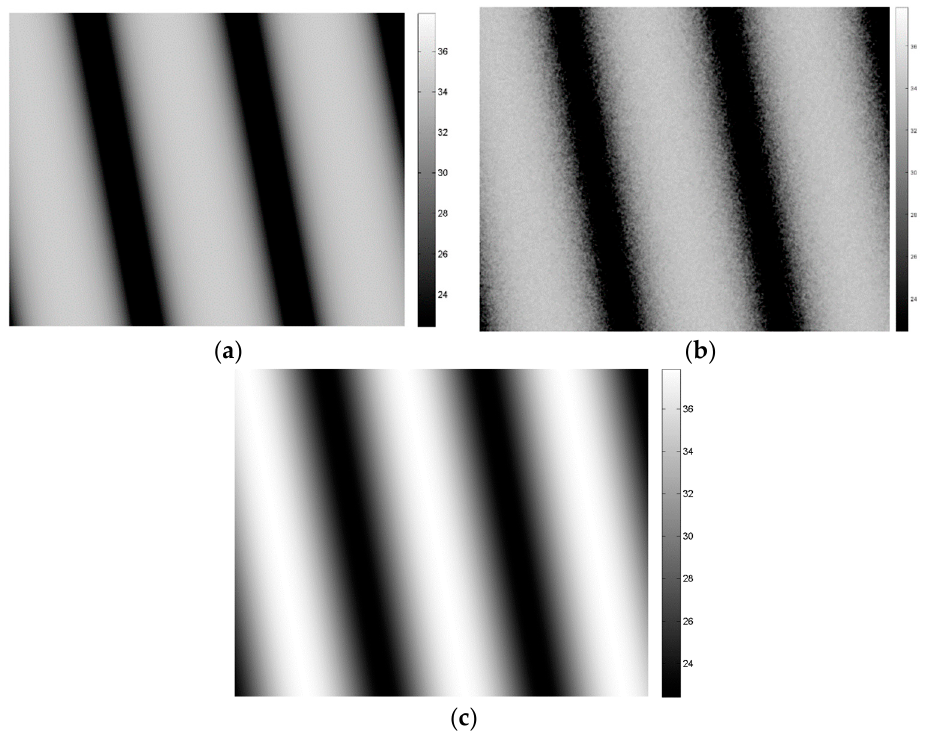
Figure 10. Local incidence angle map (in degree): ( a ) estimated from speckle-free SAR image; ( b ) estimated from 10 × 10 spatial multilook SAR image; ( c ) ground truth. Table 1. Quality measures for the sinusoidal DEM: speckle-free case.